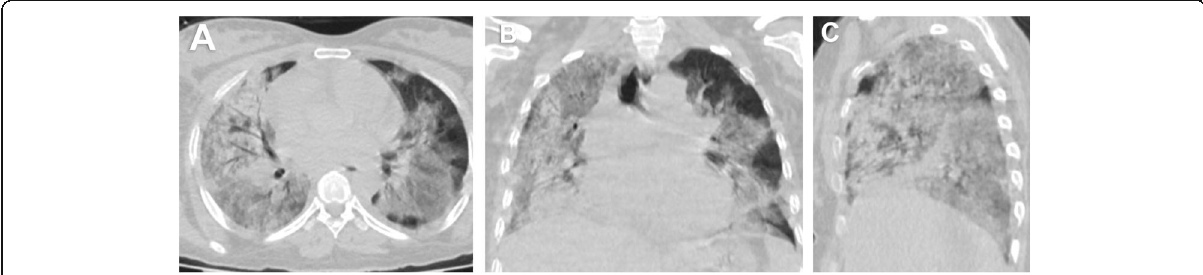
Fig. 2 A 30-year-old female patient. A axial, B coronal, and C sagittal chest CT images show bilateral diffuse ground-glass opacities and consolidation with extensive pulmonary involvement (> 75%) corresponds to current chest CT score 22 and simple chest CT score 5 (extensive affection). The patient died on the fifth